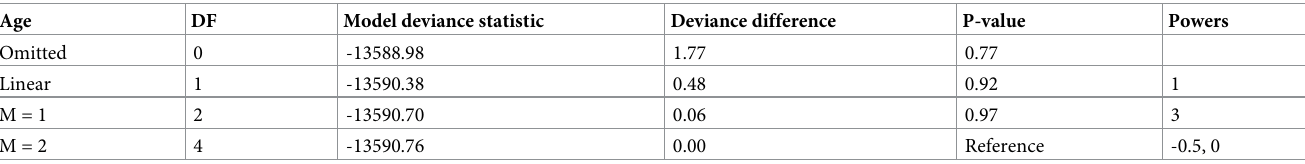
The linear model (second row) is default. The degree-of-freedom column headed ‘DF’ shows the number of additional parameters used in each FP model beyond the quantity of parameters in the null model. The deviance statistic (-2 log likelihood) is given in the column headed ‘Model deviance statistic’. The difference in deviances from the lowest value is given in the column headed ‘Deviance difference’. The P -value comparison of these differences is shown in the penultimate column. Powers are given in the last column headed ‘Powers’. Statistically, the model with the ‘best fit’ is the one with the lowest deviance; here this model has powers (-0.5, 0). Note that none of the FPs were statistically significant from the model with the lowest deviance.